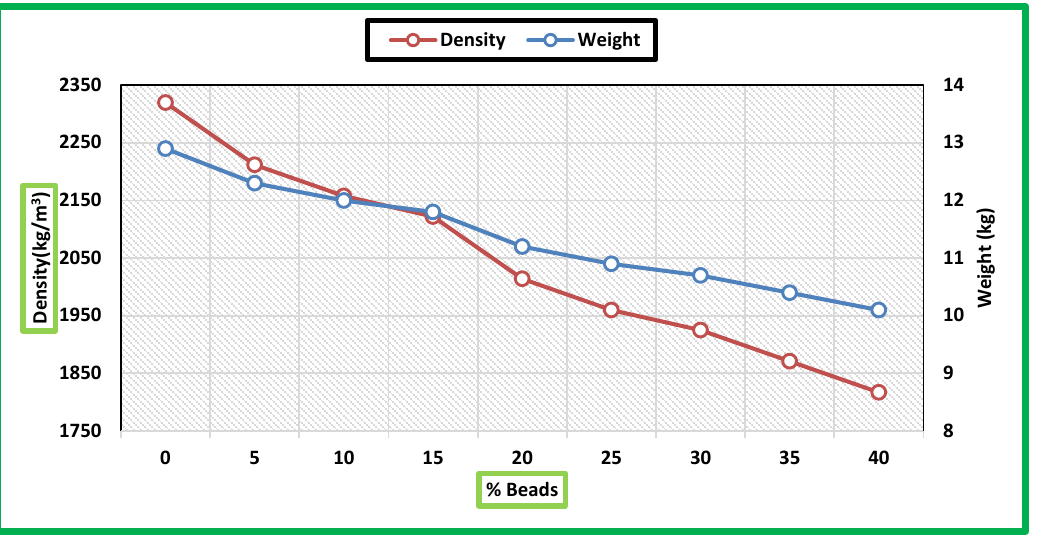
Figure 7. Beads vs. Density (Weight).